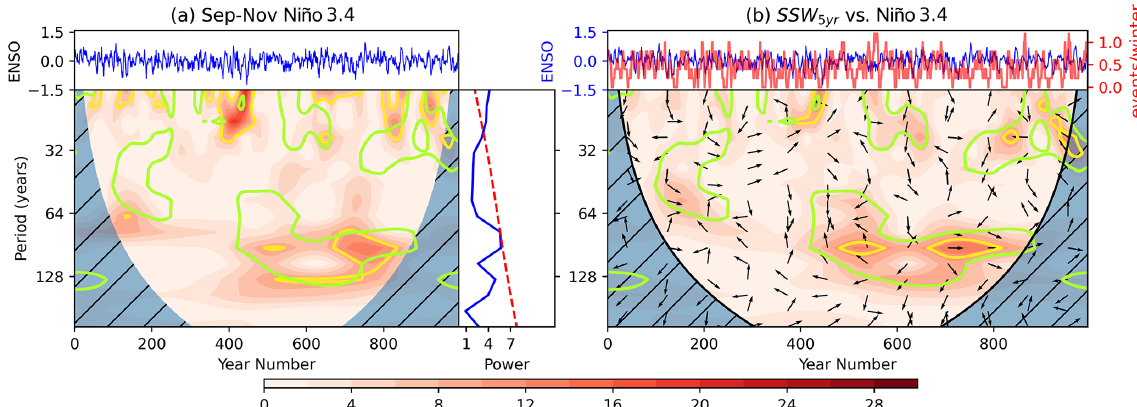
Figure 8. (a) Top: Niño 3.4 time series; bottom left: wavelet power spectrum (shaded contours represent wavelet power and yellow contours the 95% significance level compared to an AR1 process); bottom right: global wavelet power spectrum (blue) and 95% confidence level (dashed red). (b) Cross spectra between SSW 5 years and the Niño 3.4 index; top: Niño 3.4 and SSW 5 years time series; bottom: cross-power spectrum. Shading indicates cross power, yellow contours the 95% confidence interval and arrows the relative phase angle between signals in the time series (to the right: in phase; vertically upwards: π out of phase with SSWs leading; to the left: π out of phase; vertically downwards: 2 π out of phase Niño 3.4 leading). Green contours on both spectra represent the 95% confidence intervals for the wavelet power spectrum of 2 SSW 5 years .